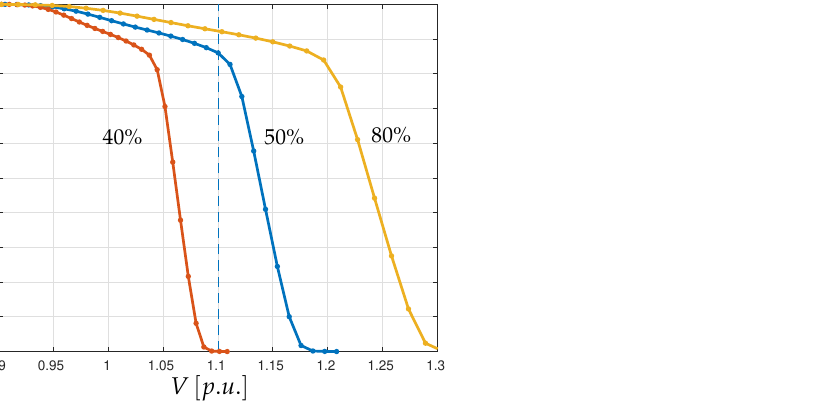
Figure 9. Probability of violating upper value V for growing penetration levels α computed with PWL method.